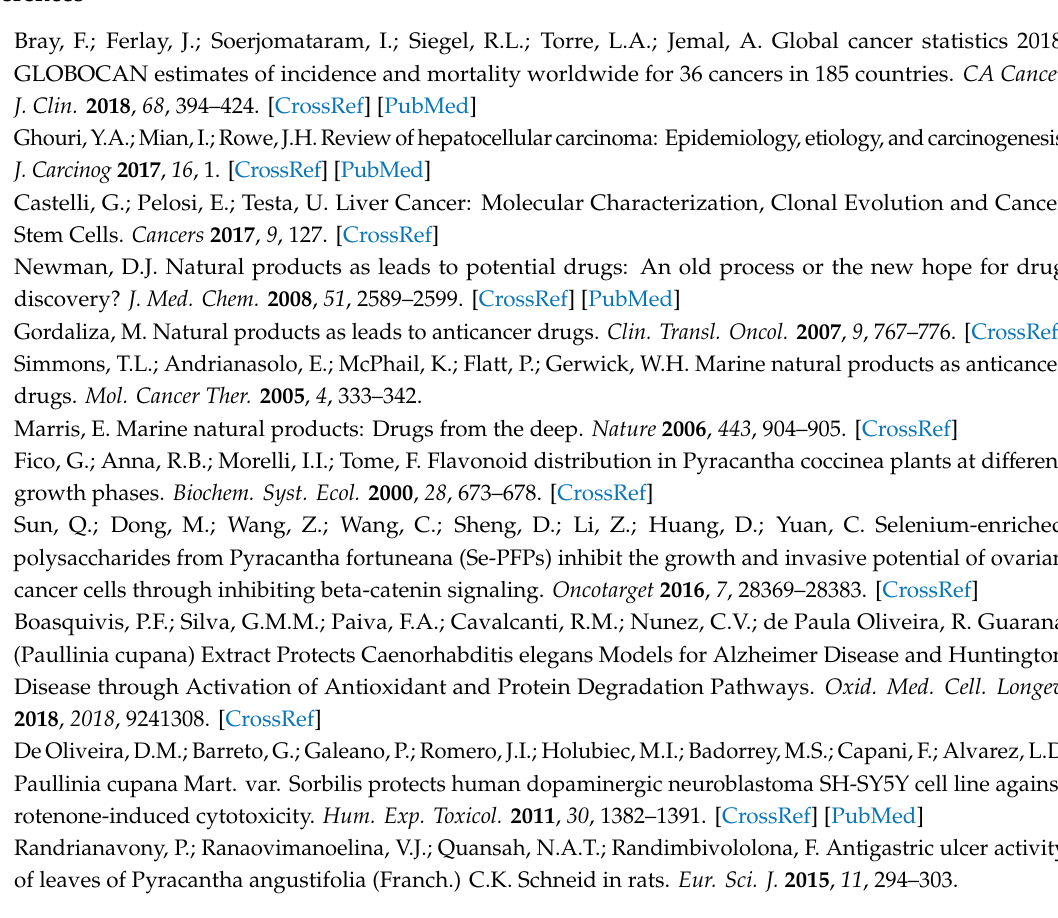
Table S1: Cytotoxicity (IC50 values µ g / ml) for eight plant extracts against MDA-MB231 and HEPG2 cancer cell line calculated at 72 hr (n = 3) using GraphPad prism software based on fit spline smoothing curve fitting function., Table S2: E ff ects of Pyracantha and Paullinia plant extracts on the cell cycle of cancer cell lines MDA-MB231 and HEPG2. Percentage of cancer cells in the sub-G1, G0 / G1, S and G2 / M phase were calculated using FACS suite software., Figure S1: E ff ects of Pyracantha and Paullinia plant extracts on the cell viability of HEPG2 cancer cells in presence of H 2 O 2 treatment (50 µ M concentration). * p <